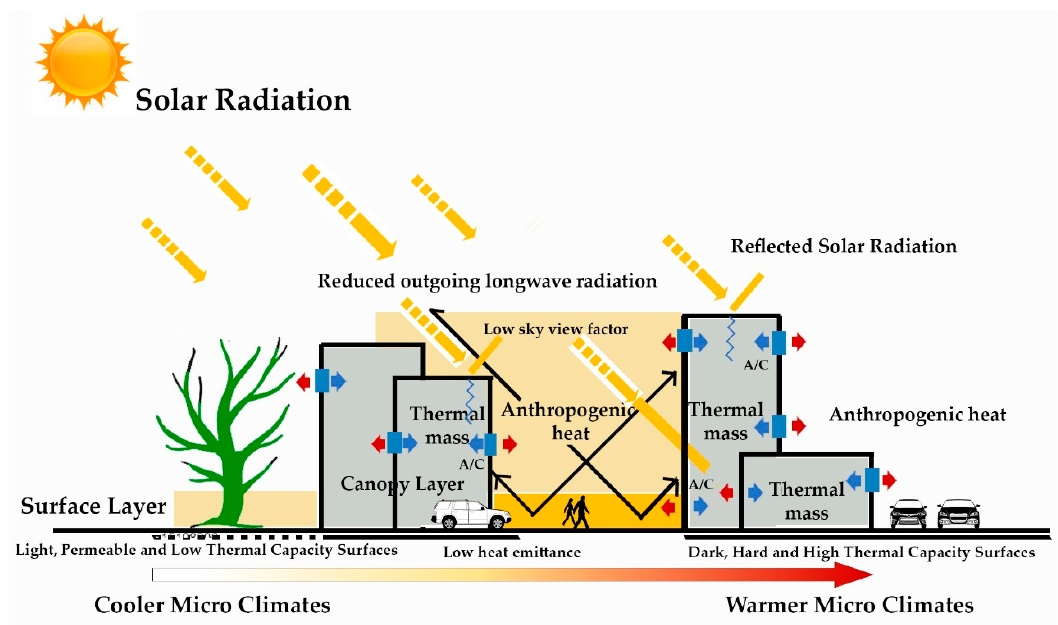
Figure 3. Urban Canopy Layer influenced by the building density and surface coverage. Source: A. Soltani and E. Sharifi, 2017.